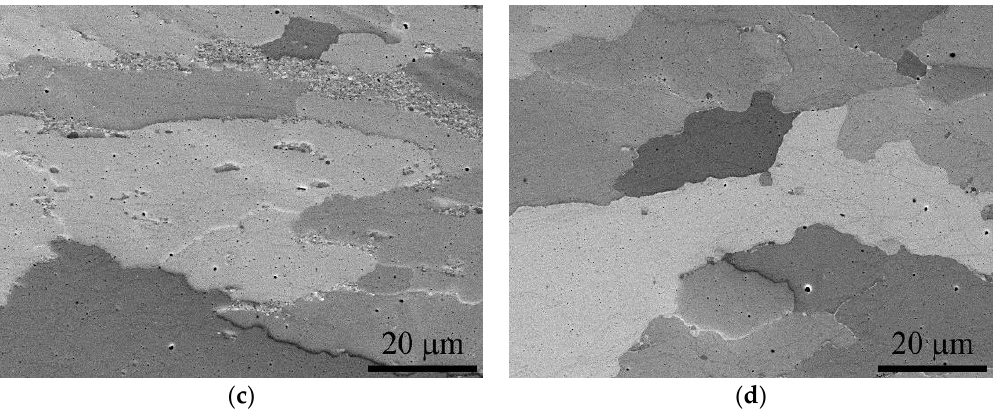
Figure 4. SEM micrographs demonstrating the evolution of the grain structure of the Fe-17Cr-7Al-4Y 2 O 3 system after ( a ) 1 h, ( b ) 2 h, ( c ) 4 h, ( d ) 24 h of annealing at 1120 ◦ C.